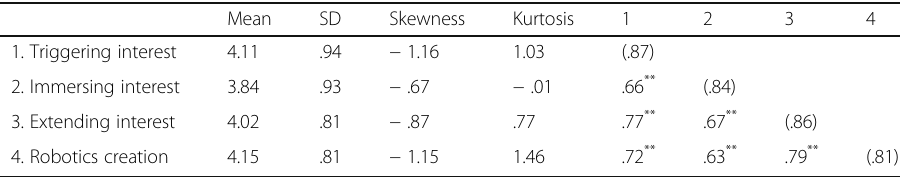
Table 1 Mean, standard deviations, and reliability coefficients of the study variables ( N = 801) Mean SD